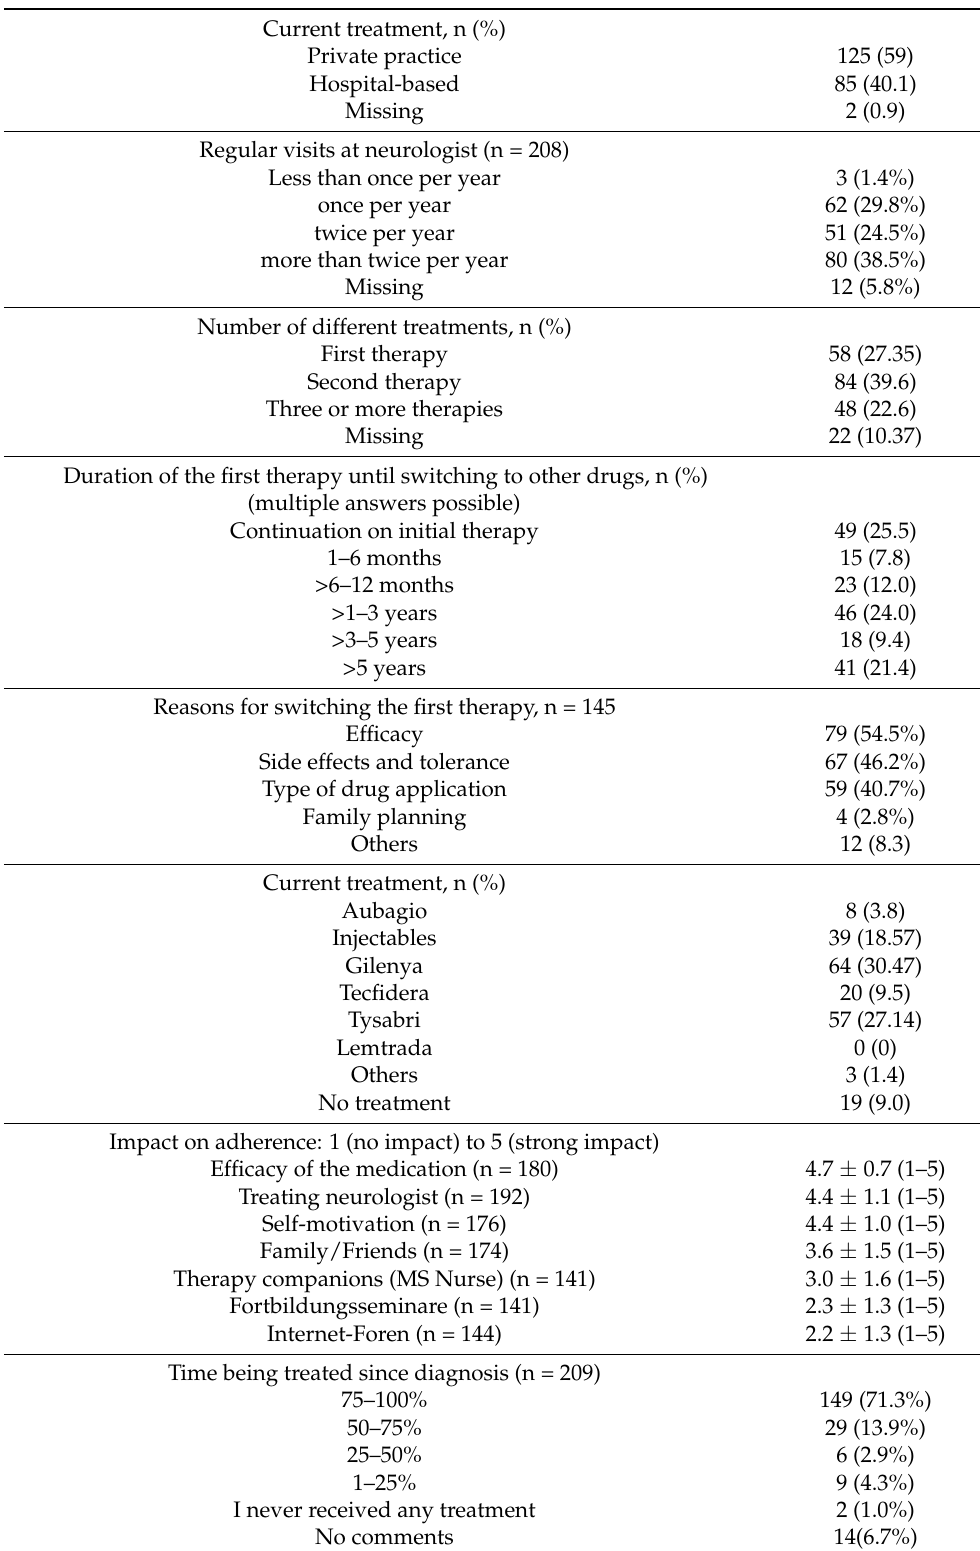
Table 4. Treatment